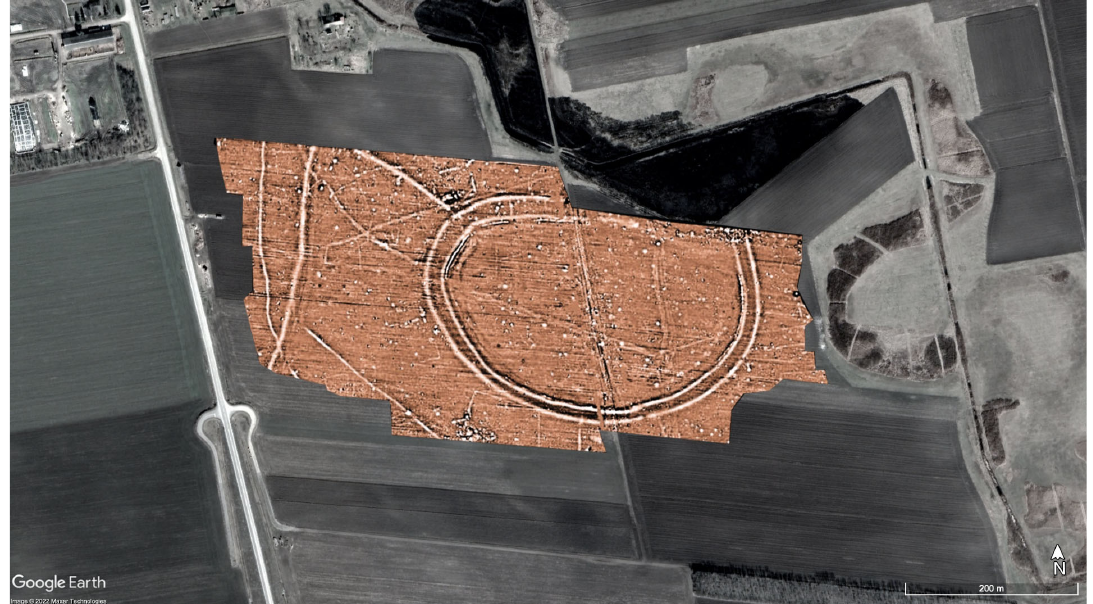
Figure 2. The magnetic map of Csanádpalota ‐ Földvár enclosure (after [53] Figure 3). This figure was created by georeferencing the image published in [53] Figure 3. The extracted RGB image was enhanced on the red band to better highlight the archaeological features. Visualisation dynamics − /+ 10 nT.